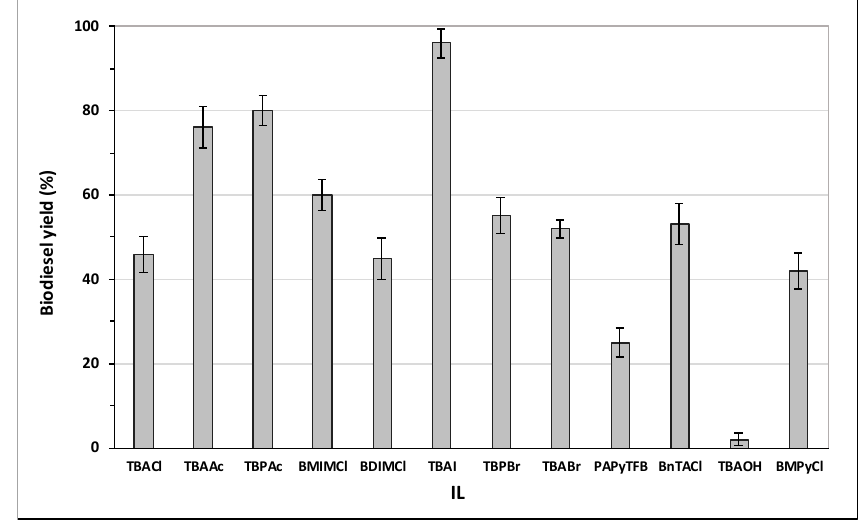
Figure 3. Effect of ionic liquid on the transesterification of soybean oil. Reaction conditions: soybean oil 0.5 mL (0.415 g), methanol 4 mL (MeOH/oil ratio = 8), ZnO 9 mg (2% w/w ), IL (30% w/w ), at 65 °C for 7 h. TBACl = Tetrabutylammonium Chloride; TBAAc = Tetrabutylammonium acetate; TBPAc = Tetrabutylphosphonium Acetate; BMIMCl = 1 ‐ butyl ‐ 3 ‐ methylimidazolium Chloride; BDIMCl = 1 ‐